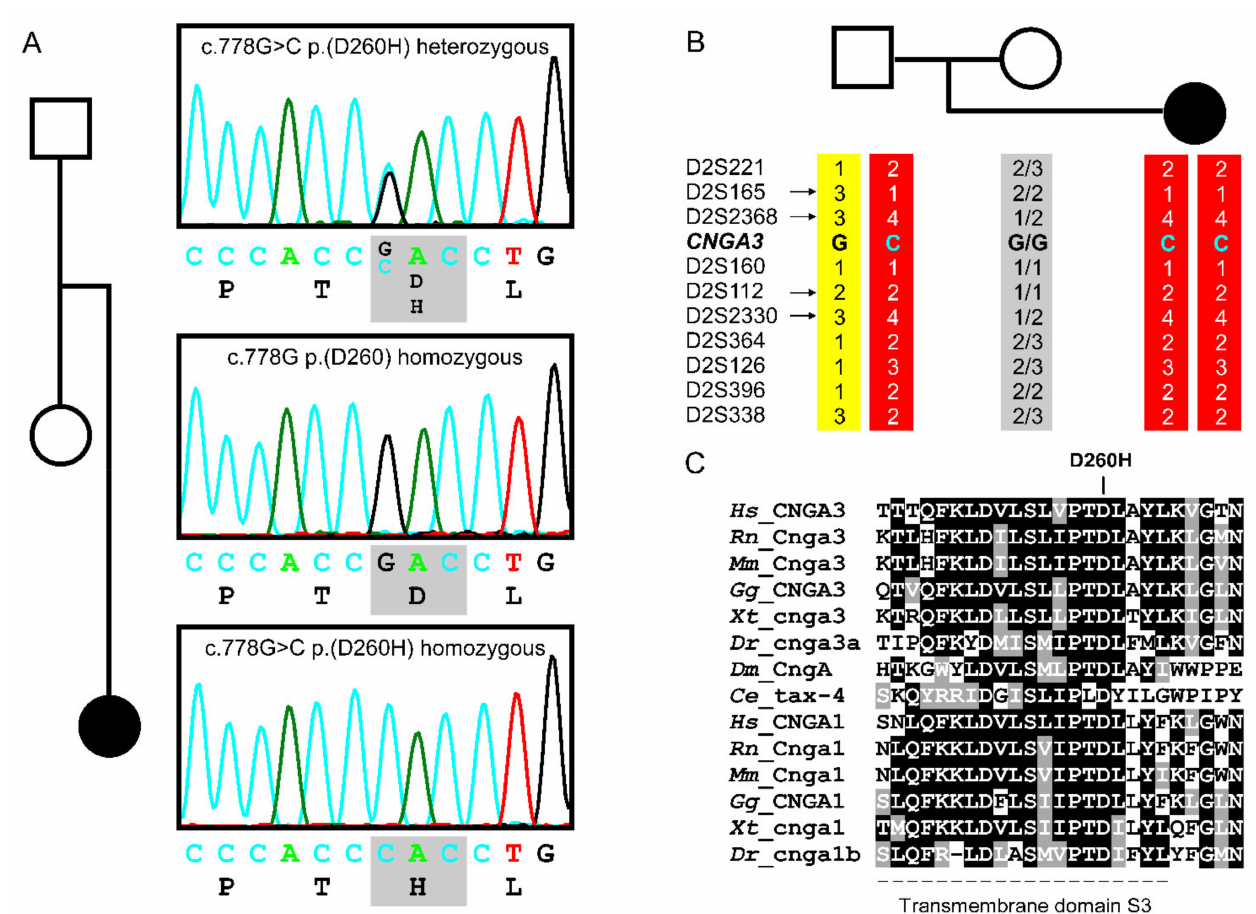
Figure 1. Segregation analysis, haplotype reconstruction, and conservation of CNGA3 c.778G>C;p.(D260H). ( A ) Segregation analysis via Sanger sequencing for CNGA3 exon 7 in family CHRO978, as shown by the electropherograms obtained from both parents and the index patient. The father is heterozygous for the variant c.778G>C (top), while the mother does not carry this variant (middle). The affected daughter is homozygous for this variant in CNGA3 (bottom). ( B ) Haplotype reconstruction of chromosome 2. Microsatellite marker analysis in the patient and both parents demonstrated paternal uniparental isodisomy of chromosome 2, either fully or partially. The patient inherited two copies (or partial chromosomal segments) of the paternal chromosome (red haplotype) carrying and flanking the CNGA3 variant c.778G>G;p.(D260H), while the maternal chromosome was not or only partially transmitted. Informative markers are marked by an arrow. Of note, the two haplotypes of the mother could not be reconstructed. ( C ) Conservation of the mutated amino acid residue CNGA3 p.D260H among CNGA3 and CNGA1 polypeptides across various species. Protein sequence alignment was performed using Clustal Omega (https://www.ebi.ac.uk/Tools/msa/clustalo/ (accessed on 16 June 2021)) and BoxShade (https://embnet.vital-it.ch/software/BOX_form.html (accessed on 16 June 2021)). Reference sequences from NCBI (https://www.ncbi.nlm.nih.gov/ (accessed on 16 June 2021)): CNGA3: H. sapiens NP_001289.1, R. norvegicus NP_445947.1, M. musculus NP_001268939.1, G. gallus NP_990552.1, X. tropicalis XP_031752880.1, D. rerio